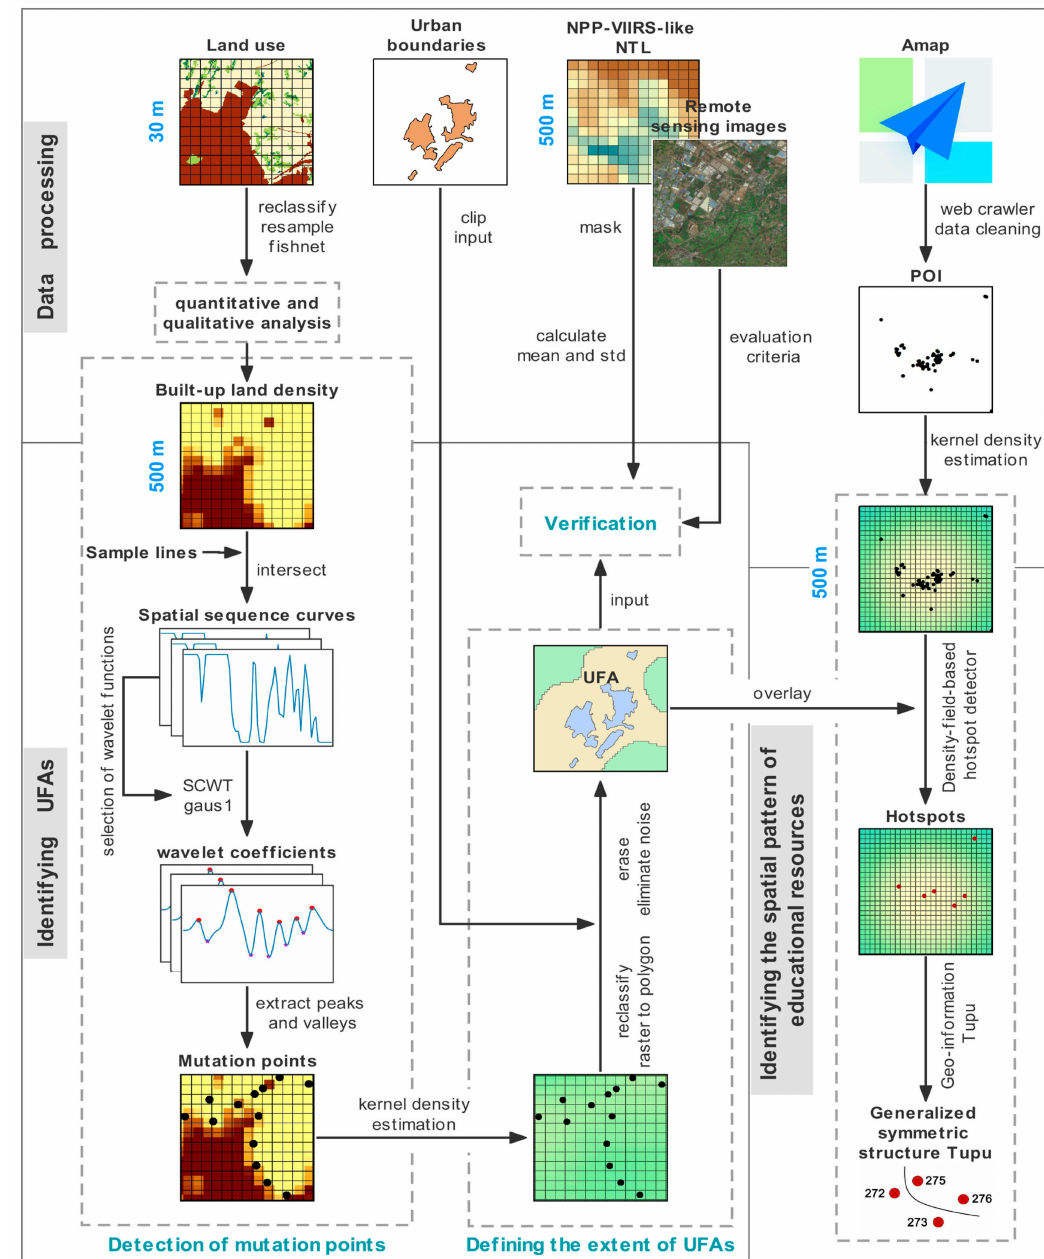
Figure 2. Workflow of this